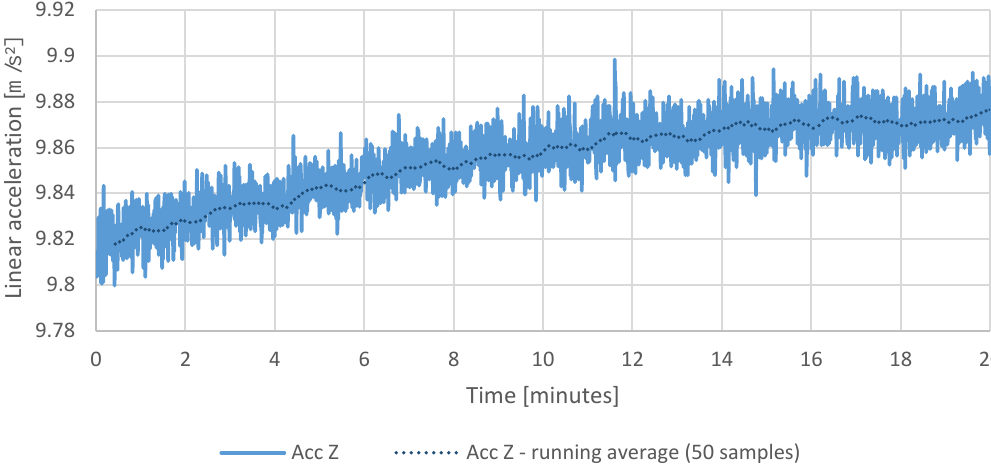
Figure 18. Stationary measurements of linear acceleration in the sensor vertical axis.